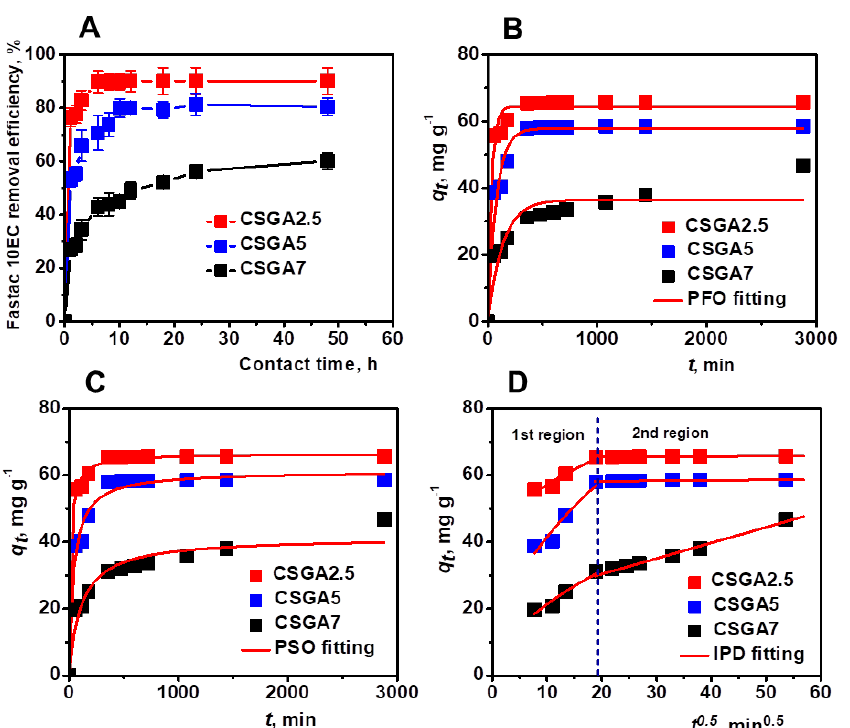
Figure 4. Effect of contact time and cross-linking degree on Fastac 10EC removal efficiency ( A ). Fastac 10EC adsorption experimental data fitted using PFO ( B ), PSO ( C ), and IPD ( D ) models. Adsorption conditions: pH 4.4, initial Fastac concentration of 0.18 mg L −1 , sorbent dose 0.025 g.